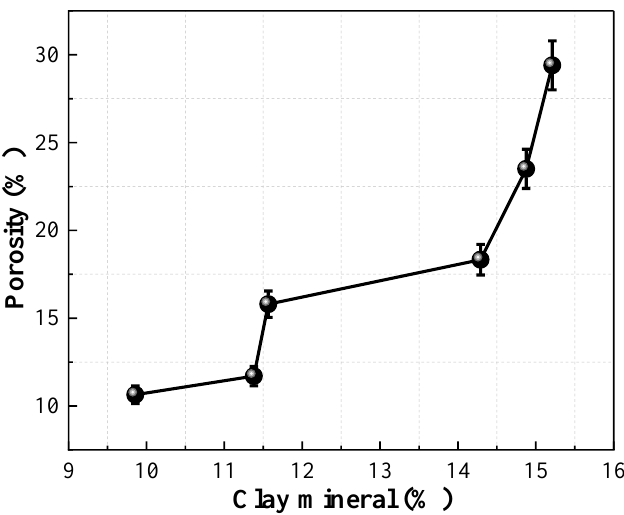
Figure 11. Relationship between porosity and clay mineral content.